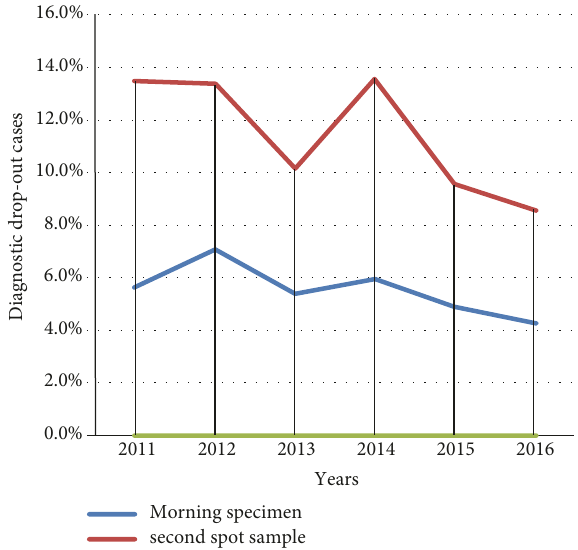
Figure 1: Trends of sputum smears positive pulmonary tuberculosis diagnostic dropout rate from